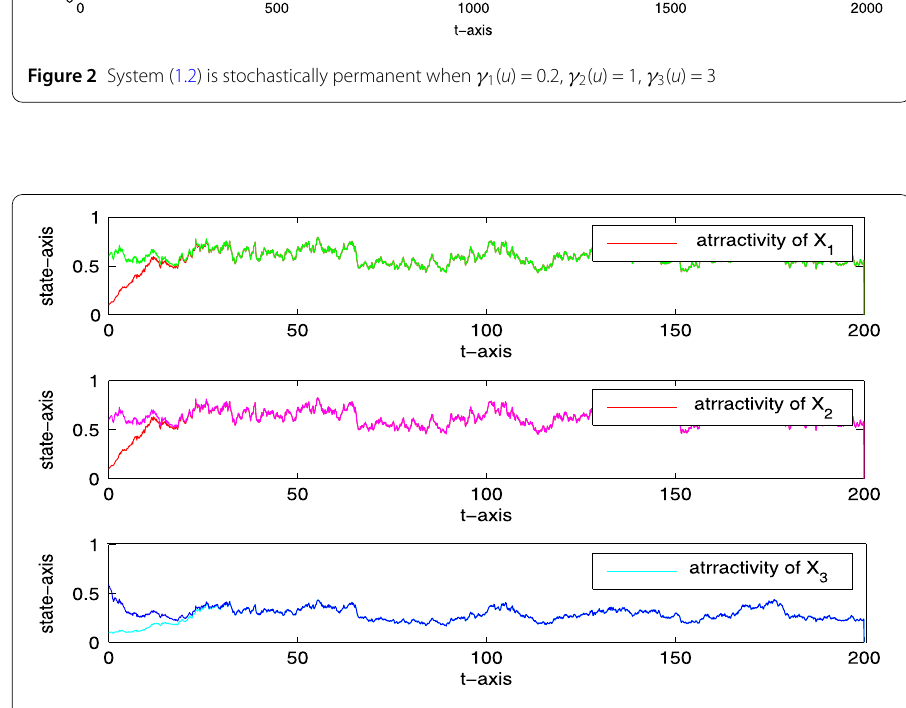
Figure 3 The attractivity of system (1.2) when σ 1 = σ 2 = σ 3 = 0.1, γ 1 ( u ) = 0.2, γ 2 ( u ) = 1, γ 3 ( u ) =